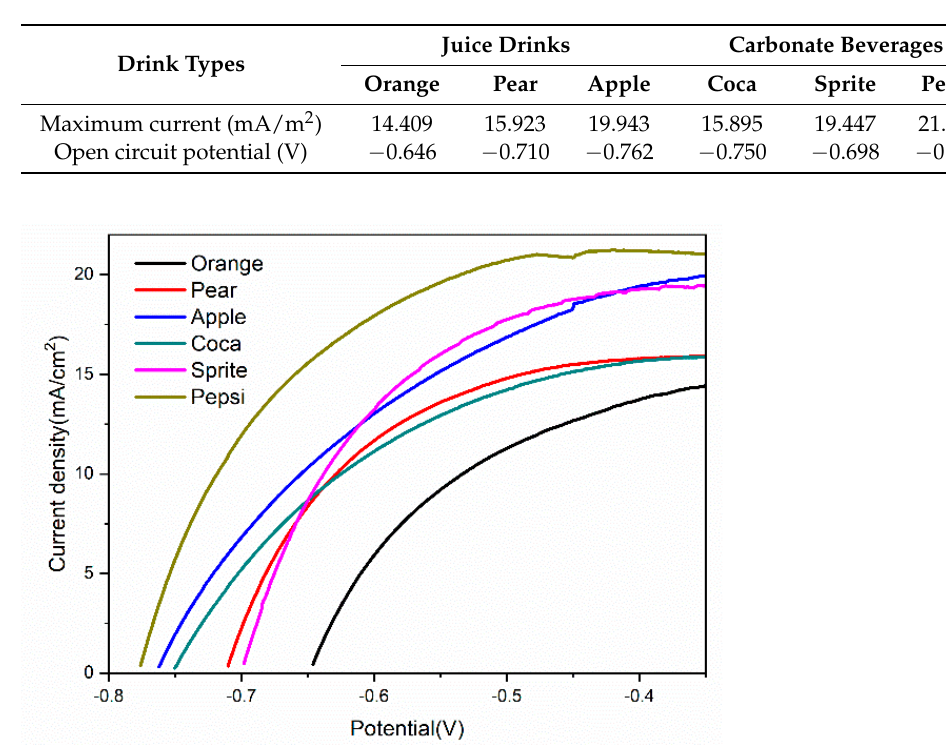
Figure 3. LSV curves of the AFC anode with different sweet drinks as